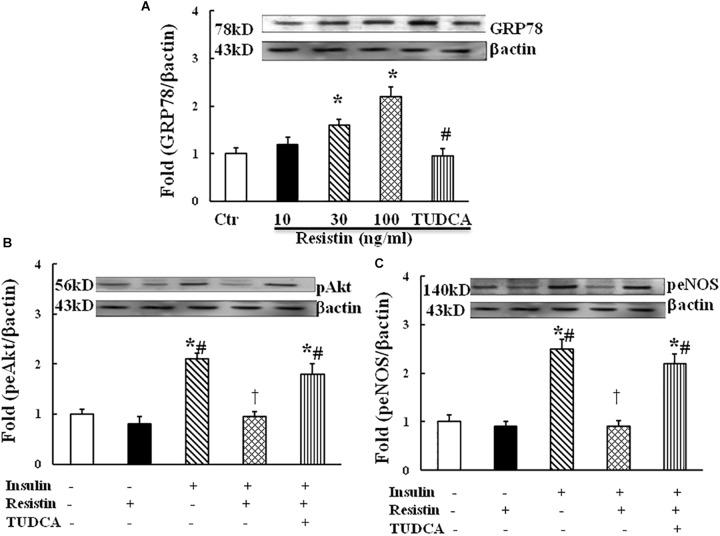
Effect of resistin on the expression of GRP78 (A, N = 7, per condition), pAkt (Ser473, B; N = 7, per condition), peNOS (Ser1177, C; N = 7, per condition) in HUVECs. Resistin (10–100 ng/mL) increased GRP78 expression in a dose-dependent manner, which was reduced by TUDCA treatment (500 μg/mL). Resistin (100 ng/mL) inhibited insulin-stimulated pAkt (Ser473) and peNOS (Ser1177) expression, TUDCA prevented an increase in the expression of pAkt and peNOS induced by resistin. Loading control imagines for βactin were reused for pAkt and peNOS. ∗p < 0.05, vs. control group, #p < 0.05, vs. correspondence resistin group, †p < 0.05 vs. insulin group.